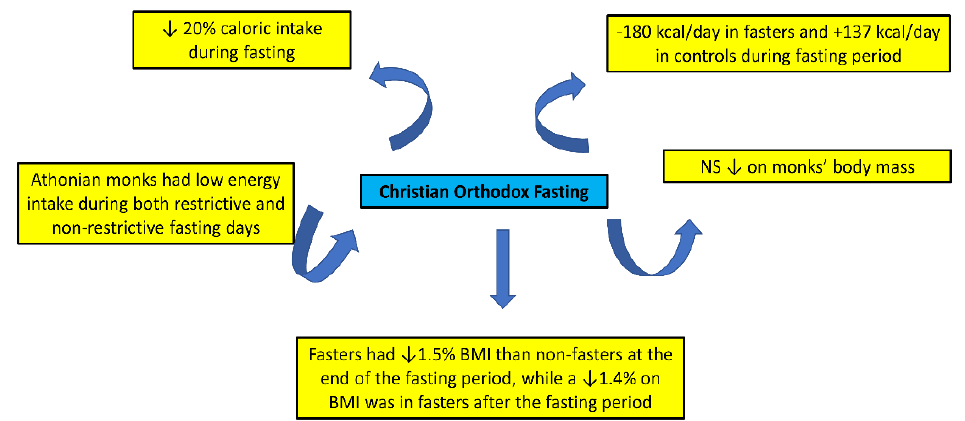
Figure 4. Potential effects of fasting concerning nutrient intakes and nutritional status ( ↓ : Decrease). Considering other macronutrient intakes during fasting, monks and fasters had lower intakes of total and saturated and trans fats [4,18], higher intakes of dietary fiber [4,19–23], and lower protein intake